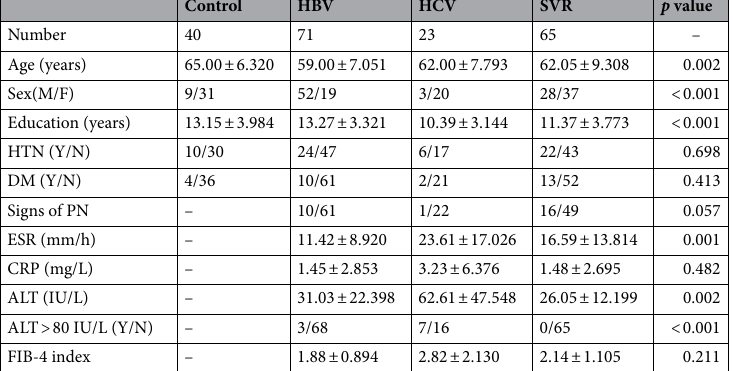
Table 2. Demographic characteristics in the study groups. Laboratory reference ranges for each of the tests: ESR: 0–15 mm/h for men and 0–20 mm/h for women; CRP: < 5 mg/L; ALT: 10–40 IU/L; FIB-4 > 3.25 had a positive predictive value for a significant fibrosis (F3-F4) of 82.1% with a specificity of 98.2% 60 . ALT alanine aminotransferase, CRP C reactive protein, DM diabetes mellitus, ESR erythrocyte sedimentation rate; HBV hepatitis B virus, HCV hepatitis C virus, HTN hypertension, PN polyneuropathy, SVR sustained virologic